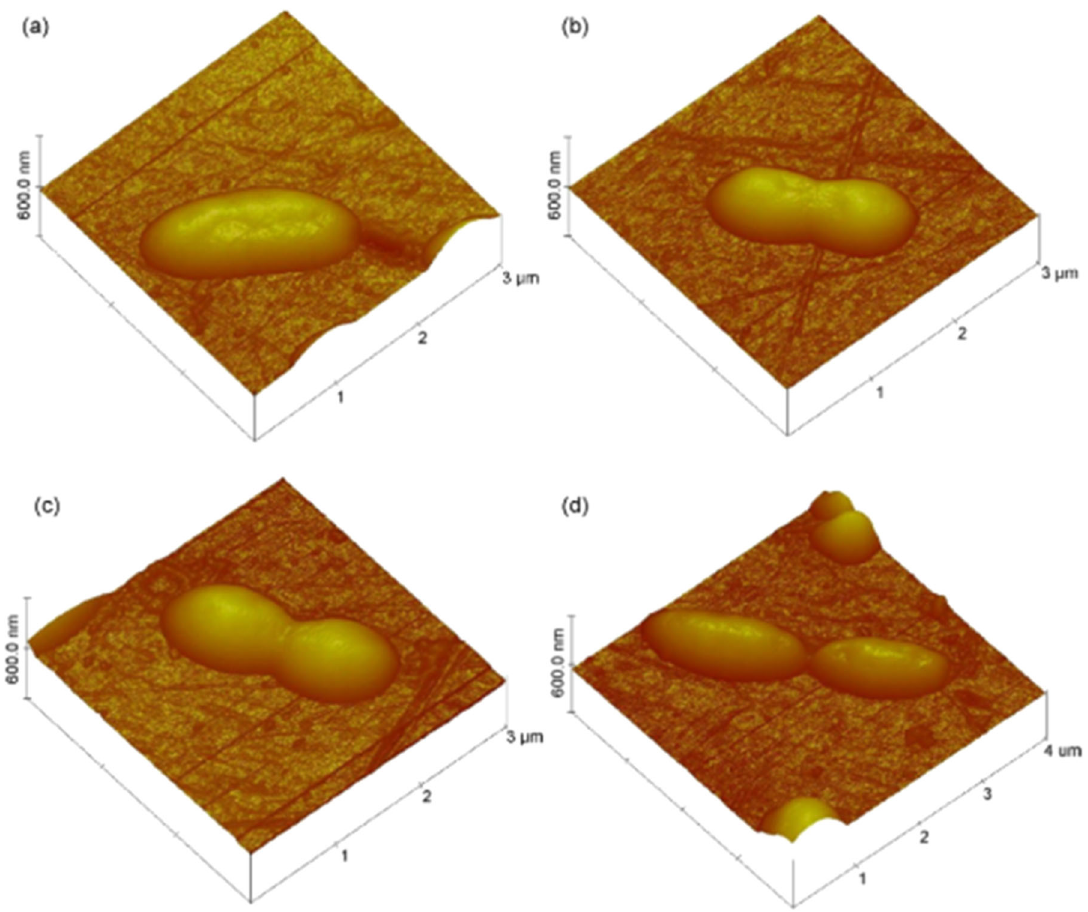
Fig. 5 AFM depicting cellular division on a steel substrate. AFM micrographs of Pseudomonas sp. undertaking binary fi ssion on stainless steel where the mature cell is seen dividing and separating into daughter cells 123